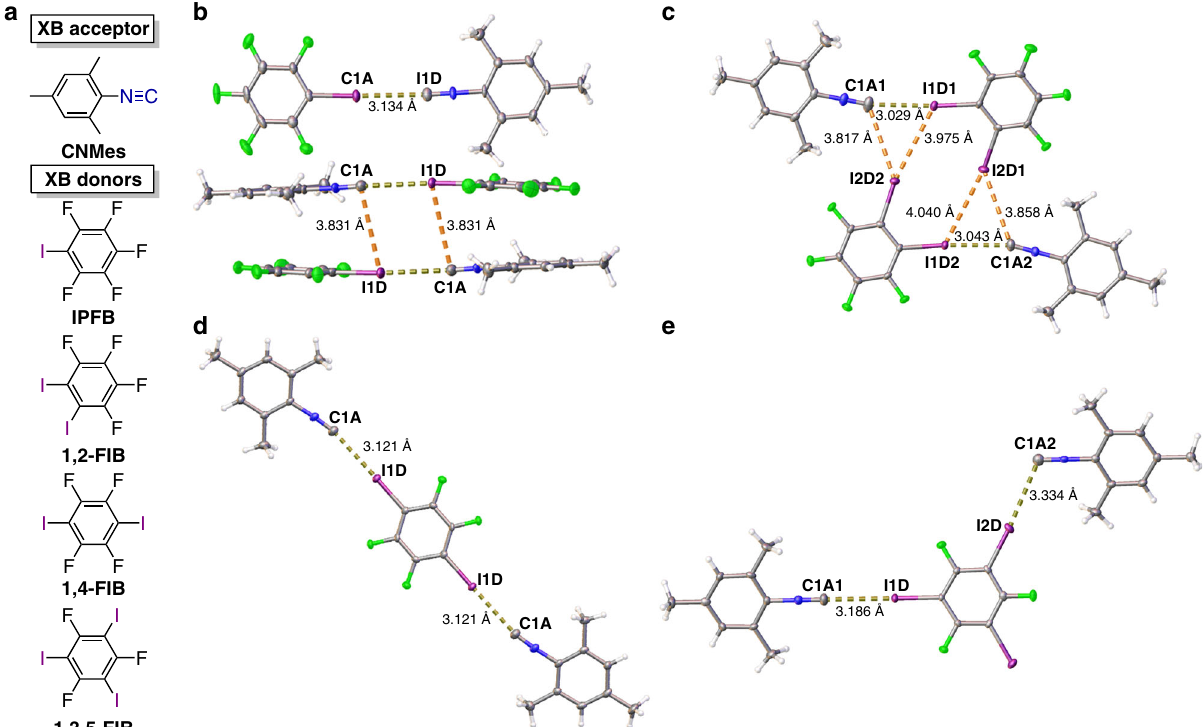
Fig. 1 XB adducts with CNMes. a Schematic view of CNMes and the iodoper fl uorobenzenes. The XRD structures of the adducts: b (CNMes) (cid:129) IPFB, c (CNMes) (cid:129) 1,2-FIB, d (CNMes) 2 (cid:129) 1,4-FIB, e (CNMes) 2 (cid:129) 1,3,5-FIB. Dotted lines indicate the identi fi ed noncovalent interactions.